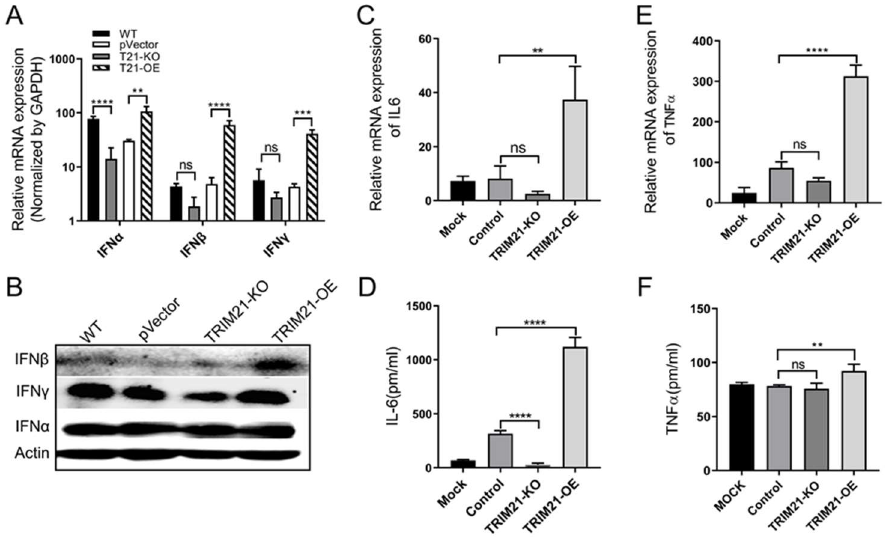
Figure 5. Porcine TRIM21 enhances interferons and proinflammatory factors in PCV2-infected cells. Error bars indicate mean values of triplicates ± the standard deviations (SD). ** p < 0.01; *** p < 0.001; **** p < 0.0001; ns, not significant. The copies of relative mRNA were normalized with GAPDH. ( A , B ) IFN. Cells were infected with PCV2 for 72 h, followed by qRT-PCR ( A ) and Western blot ( B ) assays. Mouse IFN-α antibody (1:400), rabbit IFN-β antibody (1:800), mouse IFN-γ antibody (1:500),